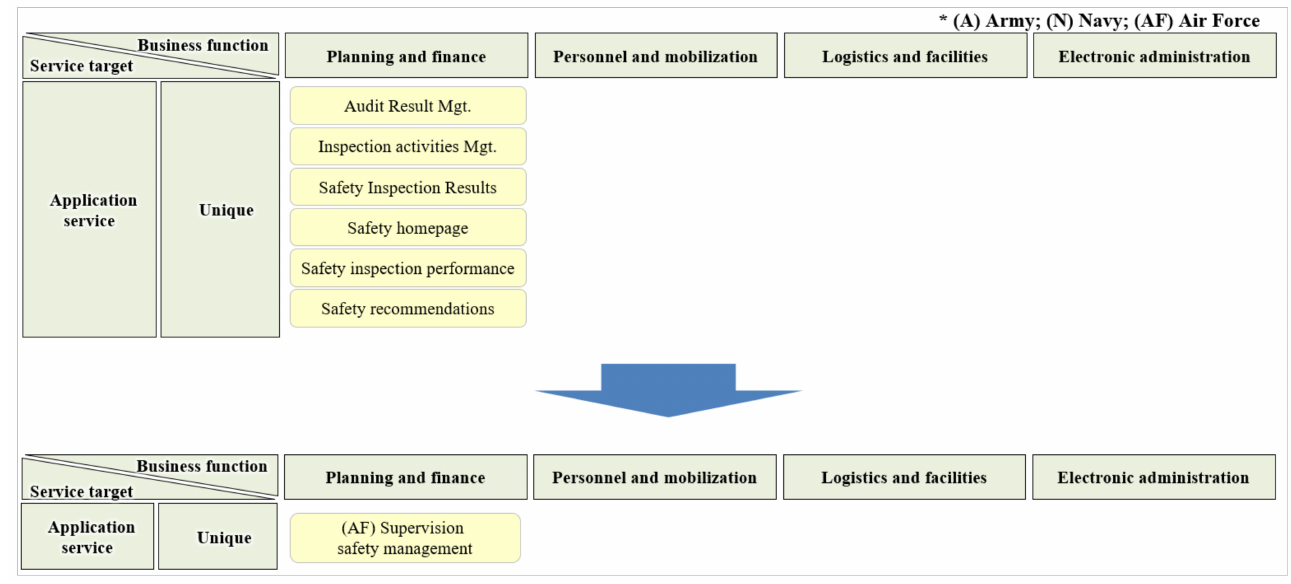
Figure 4. Example of integration of unique services in the Air Force.